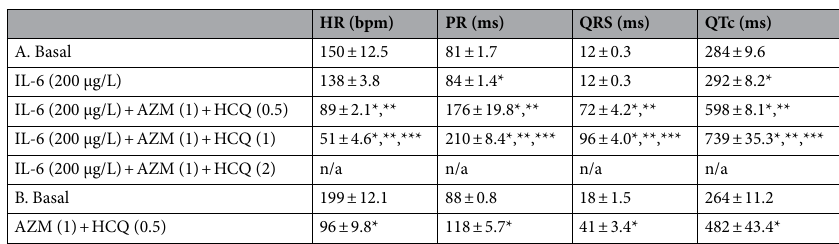
Table 2. In-vitro impact of the combination of IL-6, HCQ and AZM on Langendorff perfused guinea pig hearts. All values are expressed as mean ± SE, n = 5 guinea pigs for (A) and n = 5 guinea pigs for (B). In panel (A), paired t-test was used to compare data before (basal) and after the drugs; each guinea pig heart is used as its own control. One-way repeated measures analysis of variance was used to compare data among the treatments of IL-6 alone and in combination with AZM and HCQ for HR, PR, QRS and QRS in the same group of isolated hearts. * p < 0.05 versus Basal; ** p < 0.05 versus IL-6 (200 μg/L); *** p < 0.05 versus parenthesis indicate the corresponding multiple(s) of clinically relevant concentration (CRC). QTc = QT/RR 1/3 . HR heart rate, IL-6 Interleukin-6, AZM azithromycin, HCQ Hydroxychloroquine. AZM (1) = 41.5 mg/L; HCQ (0.5) = 24.9 mg/L; HCQ (1) = 49.8 mg/L; HCQ (2) = 99.6 mg/L. n/a: not applicable because of the asystole.